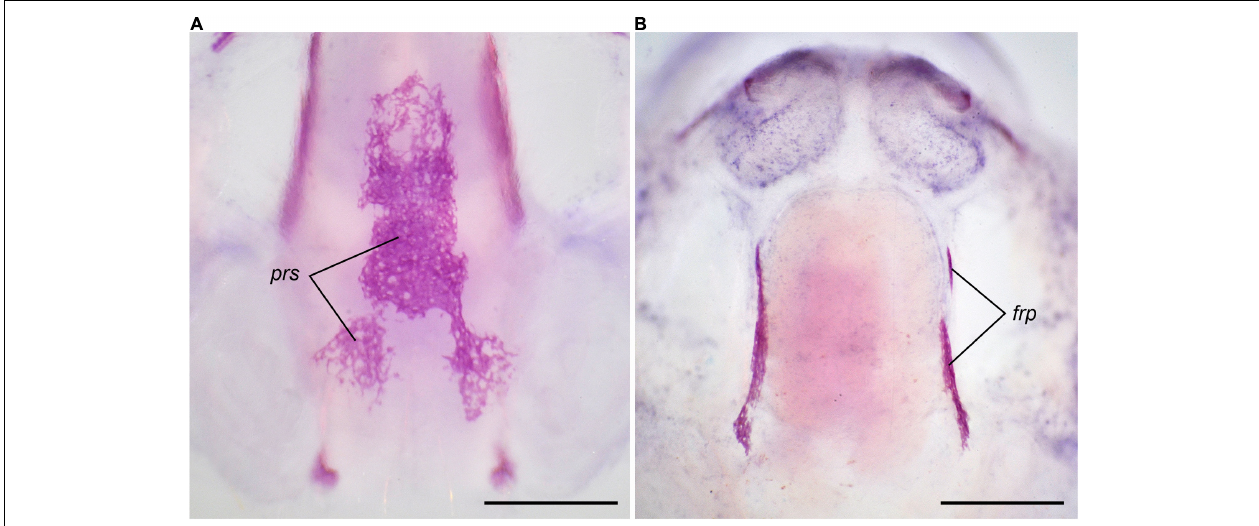
FIGURE 5 | Multiple ossification centers in Bombina variegata at T 3 2 × 10 − 8 M (late): (A) in the parasphenoid, Stage 37, 24 dph (B) in the frontoparietal, Stage 36, 22 dph. For abbreviations, see Figures 1 , 2 . Scale bar 1 mm.